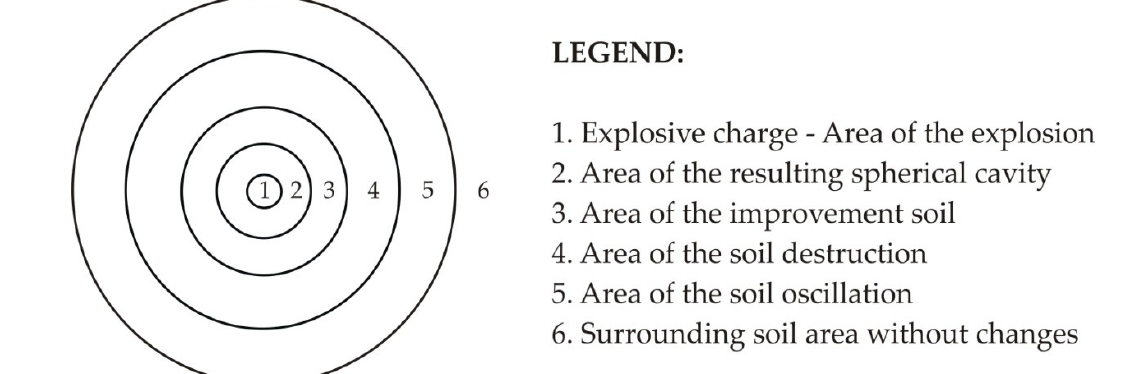
Figure 1. Spherical cavity blasting phases ( a ) Before the detonation of the explosive charge; ( b ) After detonation of the explosive charge; ( c ) Charging the spherical cavity of the borehole [1].